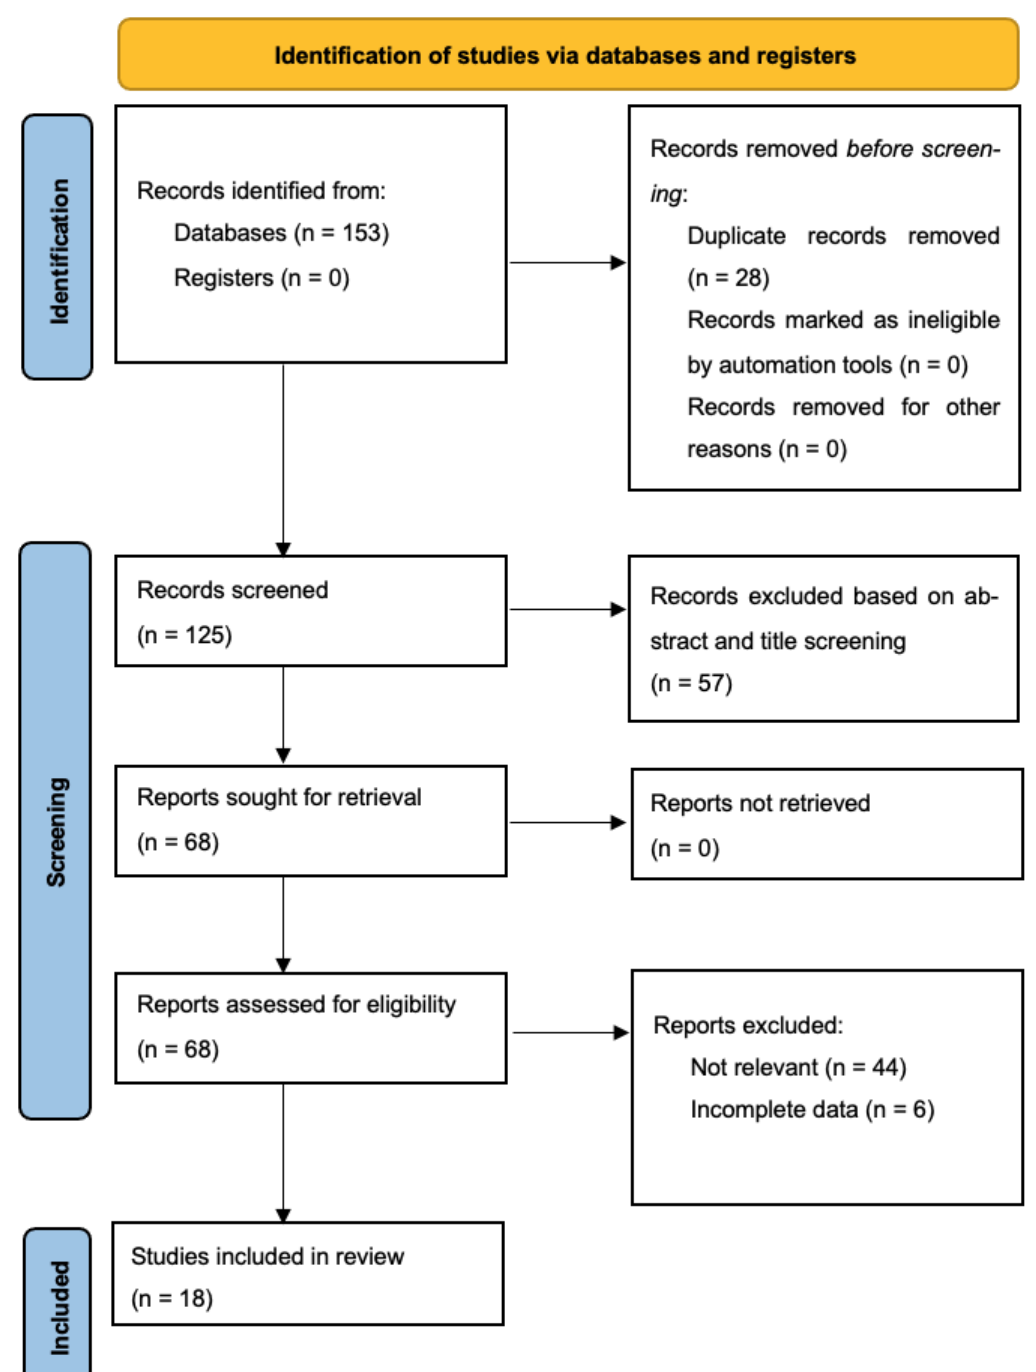
Figure 1. PRISMA Figure 1. PRISMA flowchart.